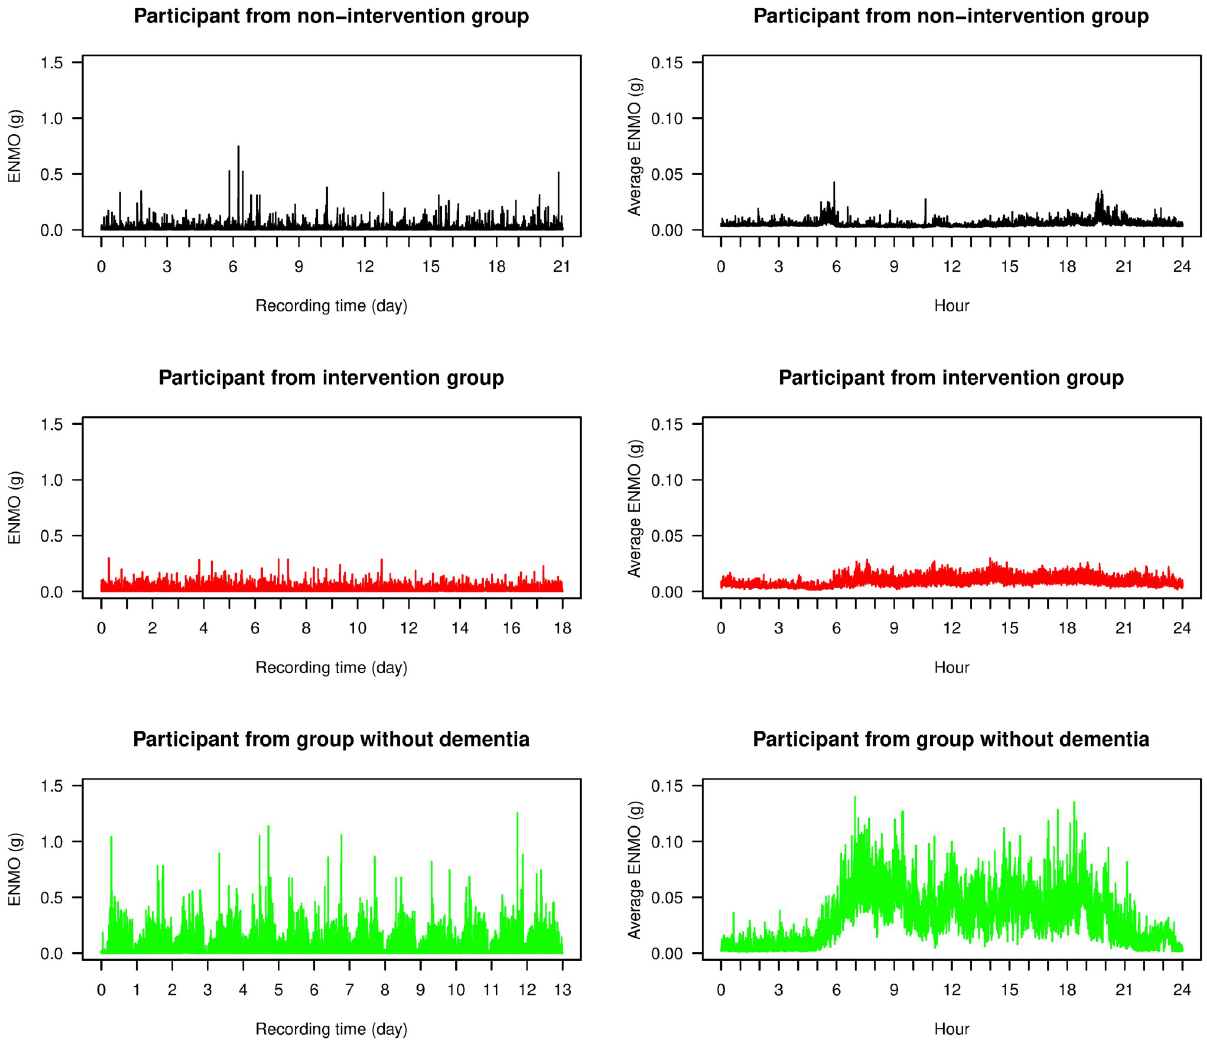
Fig 1. ENMO time series. Time series plots of ENMO data (left) and their 24-hour time average plots (right) from three participants from the study: one from each of the non-intervention group (black), the intervention group (red), and the group of individuals without dementia (green).